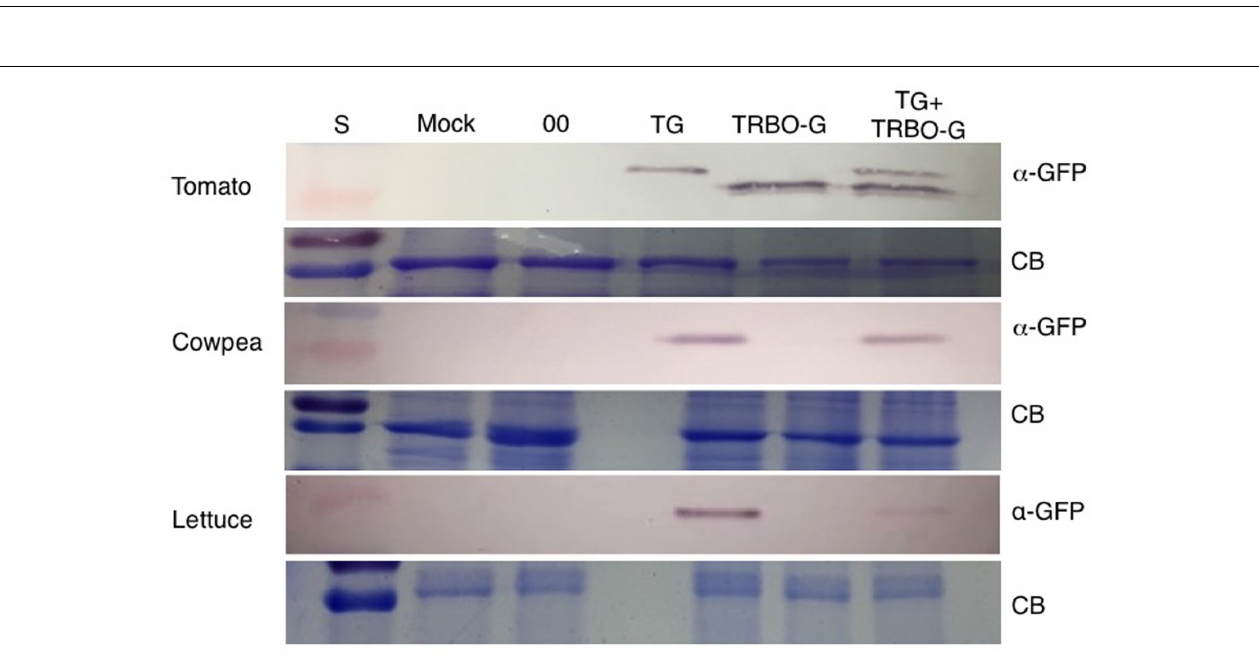
FIGURE 3 | Western blot for detection of GFP in tomato, cowpea and lettuce. TG samples were collected at 3 dpi while Mock, 00 (control Agrobacterium expressing an empty TRV vector), TRBO-G and TG+TRBO-G were collected at 7 dpi. Primary GFP antibodies were used ( α -GFP), and Coomassie Brilliant Blue (CB) staining was performed to provide loading comparisons. The red colored size marker (S) on the left of western blots is 25 kDa, while the size of the intense CB band of a host protein is about 55 kDa as inferred from the size marker on the left.